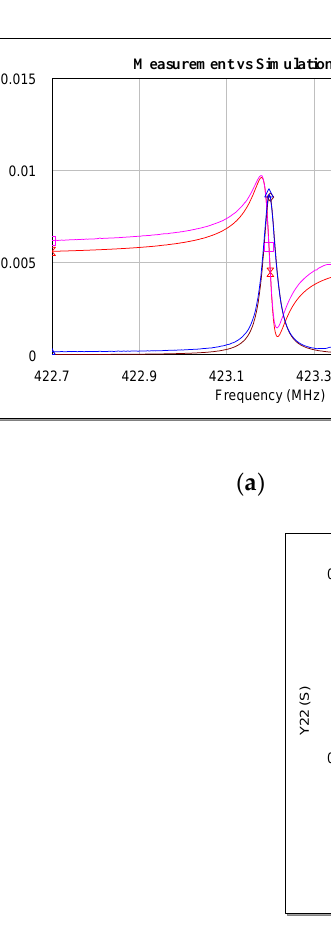
Figure 10. Comparison between measurements and simulations of the real and imaginary parts of ( a ) Y 11 , ( b ) Y 21 , and ( c ) Y 22 versus the frequency for the tested SAW resonator at 60 °C.